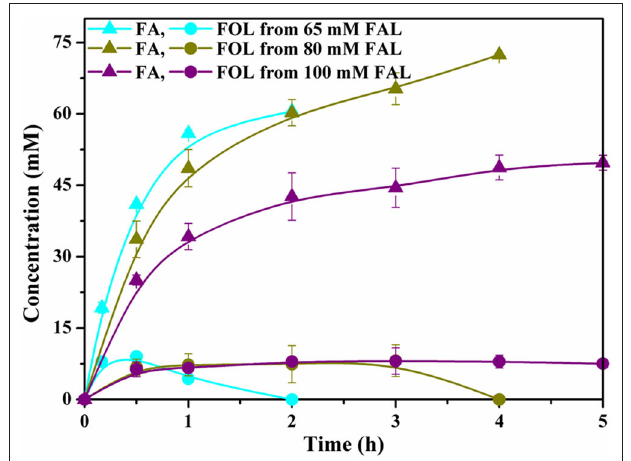
FIGURE 5 | Profiles of selective oxidation of partially purified FAL (Cyan, 65mM; Dark yellow, 80mM; Purple, 100mM) to FA under optimized biotransformation conditions.